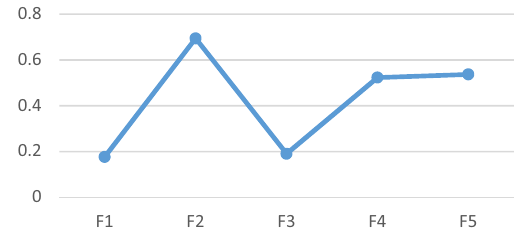
Figure 2. Ranking based on